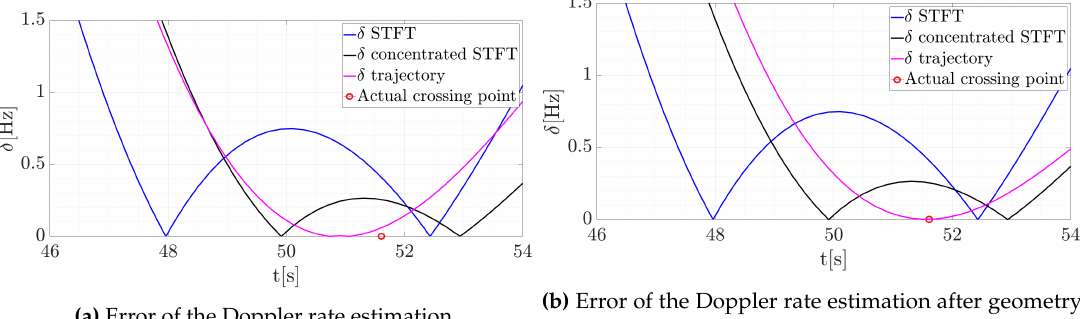
Figure 10. Absolute value of estimated errors of the Doppler rate estimation—initial error and after correction.